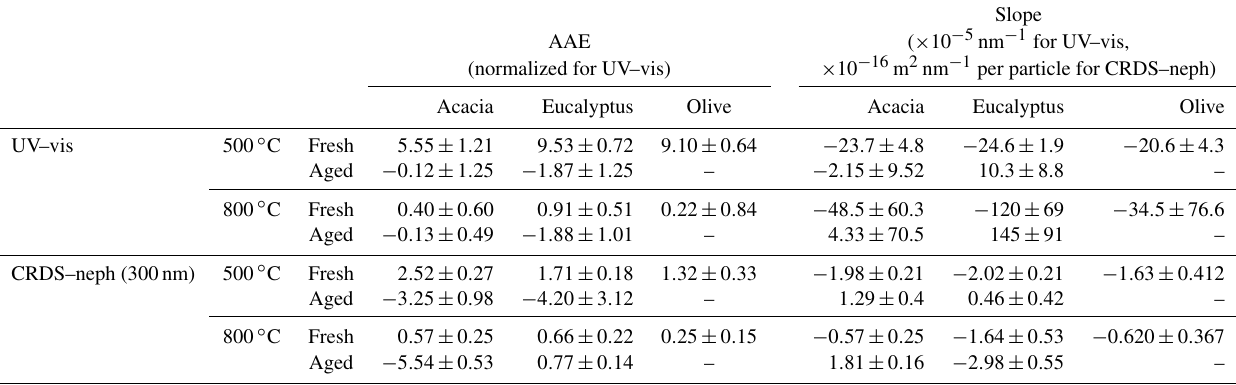
Table 4. The slope of absorption vs. wavelength and the Ångstrom absorption exponent for each sample, as measured by the UV–vis spectrum during chemical analysis (normalized) and during CRDS–nephelometer analysis (in situ). AAE was determined for the wavelength range 500nm ≤ λ ≤ 570nm. Slope AAE ( × 10 − 5 nm − 1 for UV–vis, Olive Acacia Eucalyptus